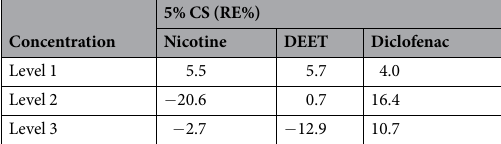
Table 4. Accuracy of the method in terms of RE% in 5% CS. For nicotine and DEET: Level 1: 25 ng mL − 1 , Level 2: 100 ng mL − 1 , Level 3: 1000 ng mL − 1 . For diclofenac: Level 1: 50 ng mL − 1 , Level 2:500 ng mL − 1 , Level 3: 5000 ng mL − 1 . N = 3; experimental conditions: same as conditions given in the text, desorption volume: 0.1